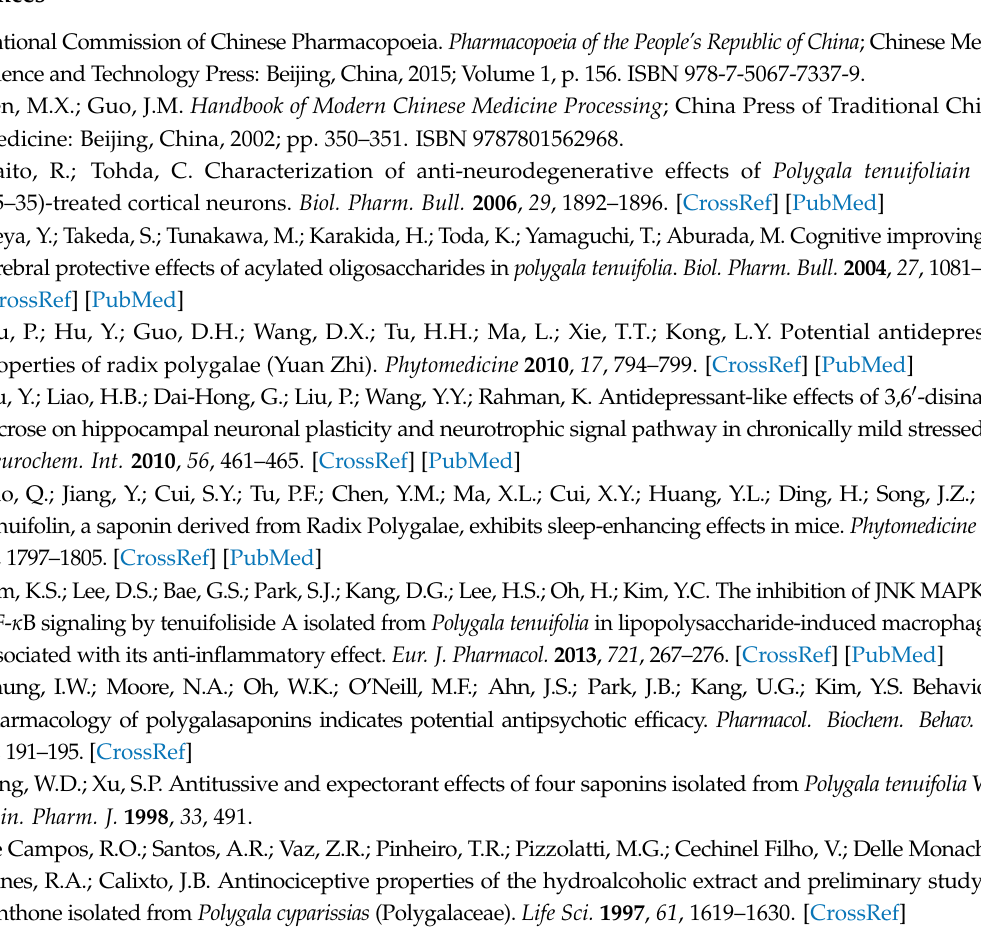
Supplementary Materials: The following are available online. Figure S1: The influence factors, the extracting from RP. Figure S2: The standardized content of bioactive compounds in RP’s xylem and phloem (*, p < 0.001), Table S1: Contents of 9 analytes in RP samples (mean ± SD, µ g/g). Table S2: The information of RP samples used in this